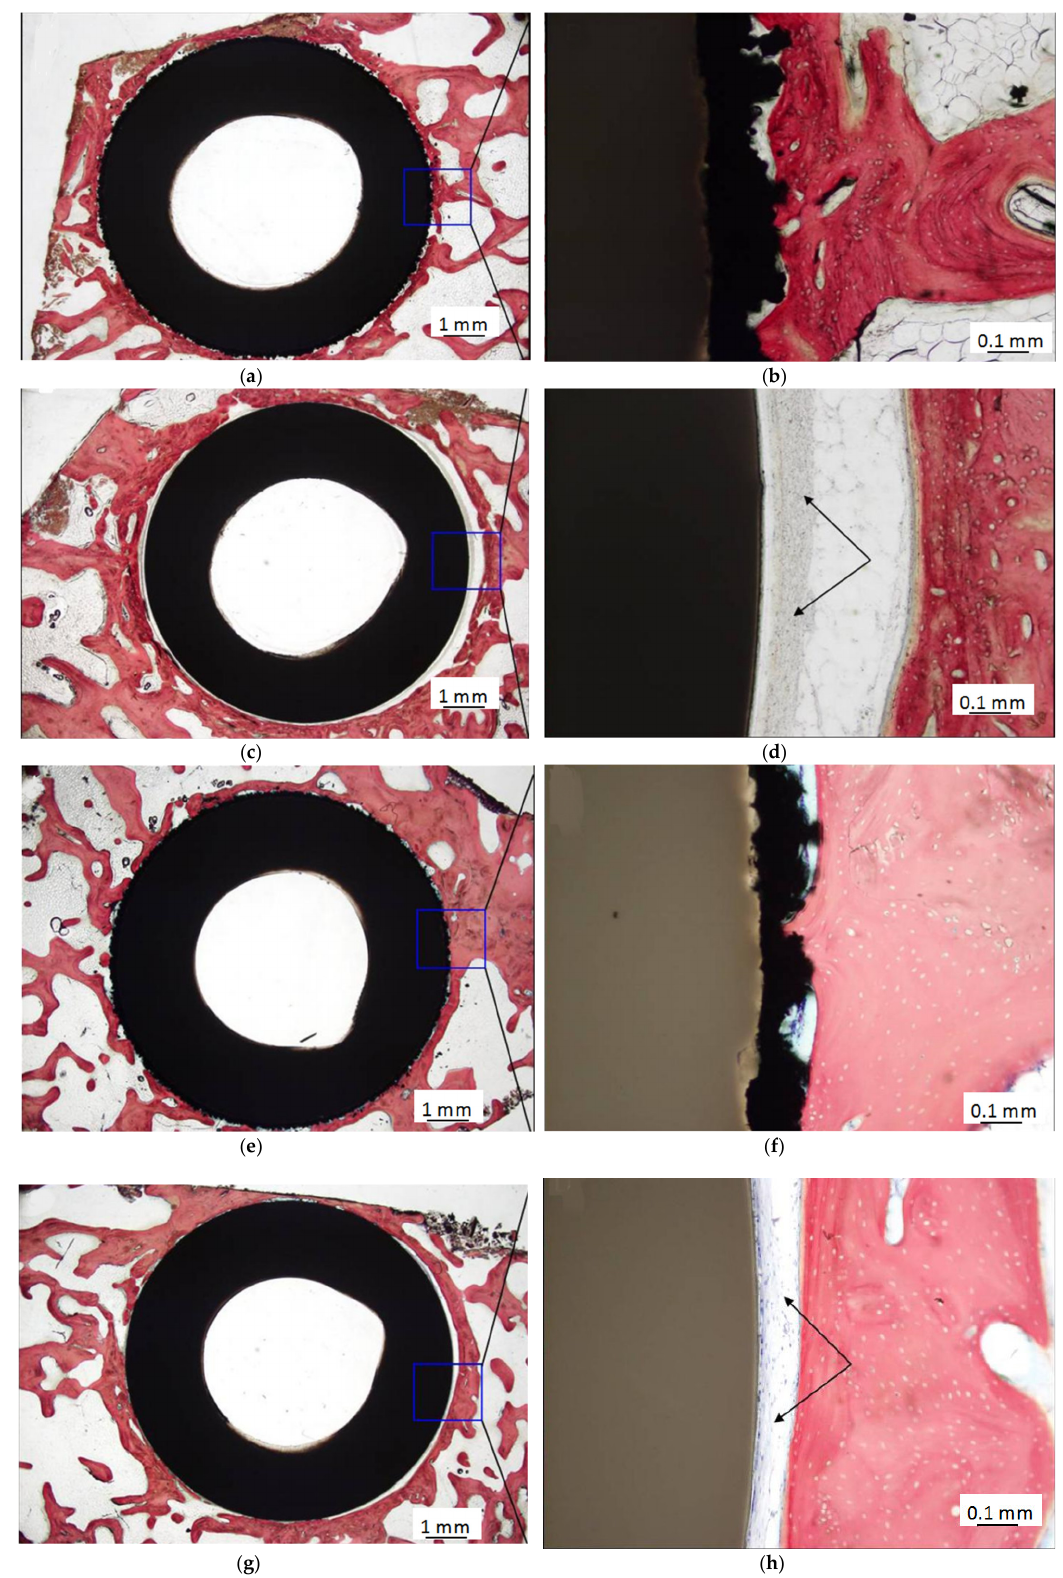
Figure 5. Histology results for Ti-PEEK implants and uncoated PEEK implants. 12 weeks for Ti-PEEK implants ( a , b ) and uncoated PEEK implants ( c , d ); 24 weeks for Ti-PEEK implants ( e , f ) and uncoated PEEK implants ( g , h ). Black arrows: fibrous connective tissue. H&E stain. Bar =1 mm ( a , c , e , g ); 0.1 mm ( b , d , f , h ). (Reproduced from [72], with permission from © 2018 Dovepress).